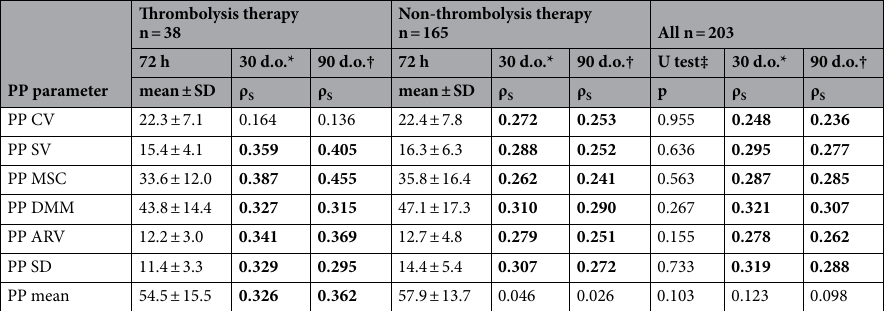
observed that correlations between mean PP values and mRS scores were only relevant in the group with throm- bolytic treatment (Table 2). The next step of the study was the logistic regression analysis for short- and long-term outcome. The unad- justed model demonstrated that all PPV indices were associated with risk of unfavorable outcome at 30 and 90 days after AIS (Table 3, Model 1). In Model 2, all PPV indices were adjusted for their mean values and the application of recombined tissue plasminogen activator (rtPA). The PPV indices were independently associ- ated with poor outcome at 30 days (OR = 4.457, 95% CI 1.961–10.132 per 10 mmHg increase in SD, p = 0.000; OR = 1.473, 95% CI 1.190–1.823 for 10 mmHg increase in MSC, p = 0.000) and 90 days (OR = 3.666, 95% CI 1.648–8.156 per 10 mmHg increase in SD, p = 0.001; OR 1.439, 95% CI 1.167–1.774 per 10 mmHg increase in MSC, p = 0.001). Very similar odds ratios (OR) were found for PPV indices when the ‘adjusted outcome’ was employed, which took into consideration both mRS and baseline NIHSS scores, as mentioned in the methods (Model 3). Model 4 was an extension of Model 2 adjusting for age, gender and history of myocardial infarc- tion. We conclude that ORs for all PPV indicators remain statistically significant, although their values steadily decrease, passing from Model 1 to Model 4. The exception are PP ARV and PP SD indices, for which the ORs